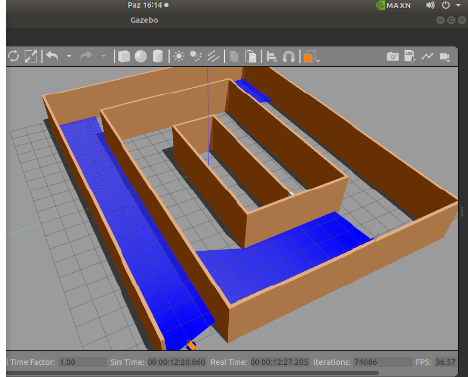
Figure 14. Side view.